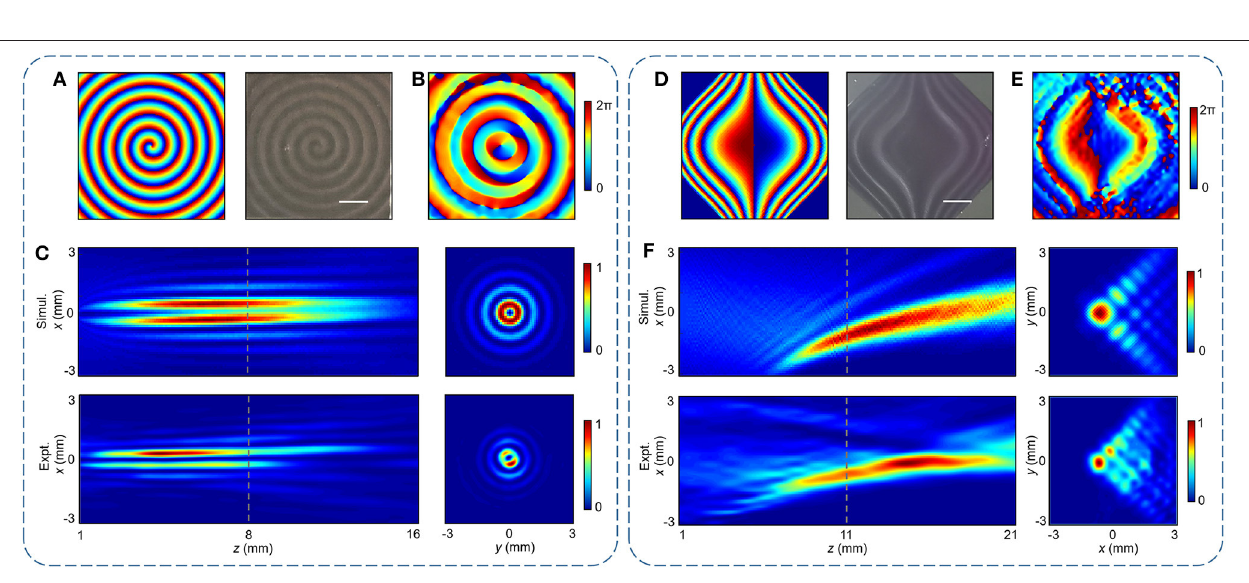
Frontiers in Physics |